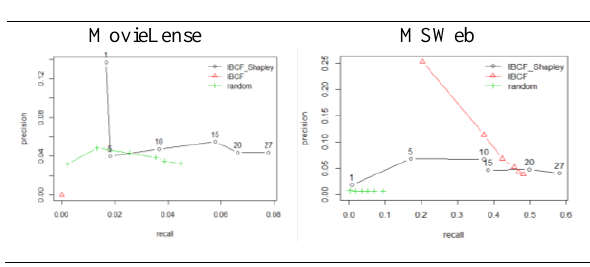
Figure 2. ROC curve of three models on MovieLense and MSWeb The experiment result of three models on